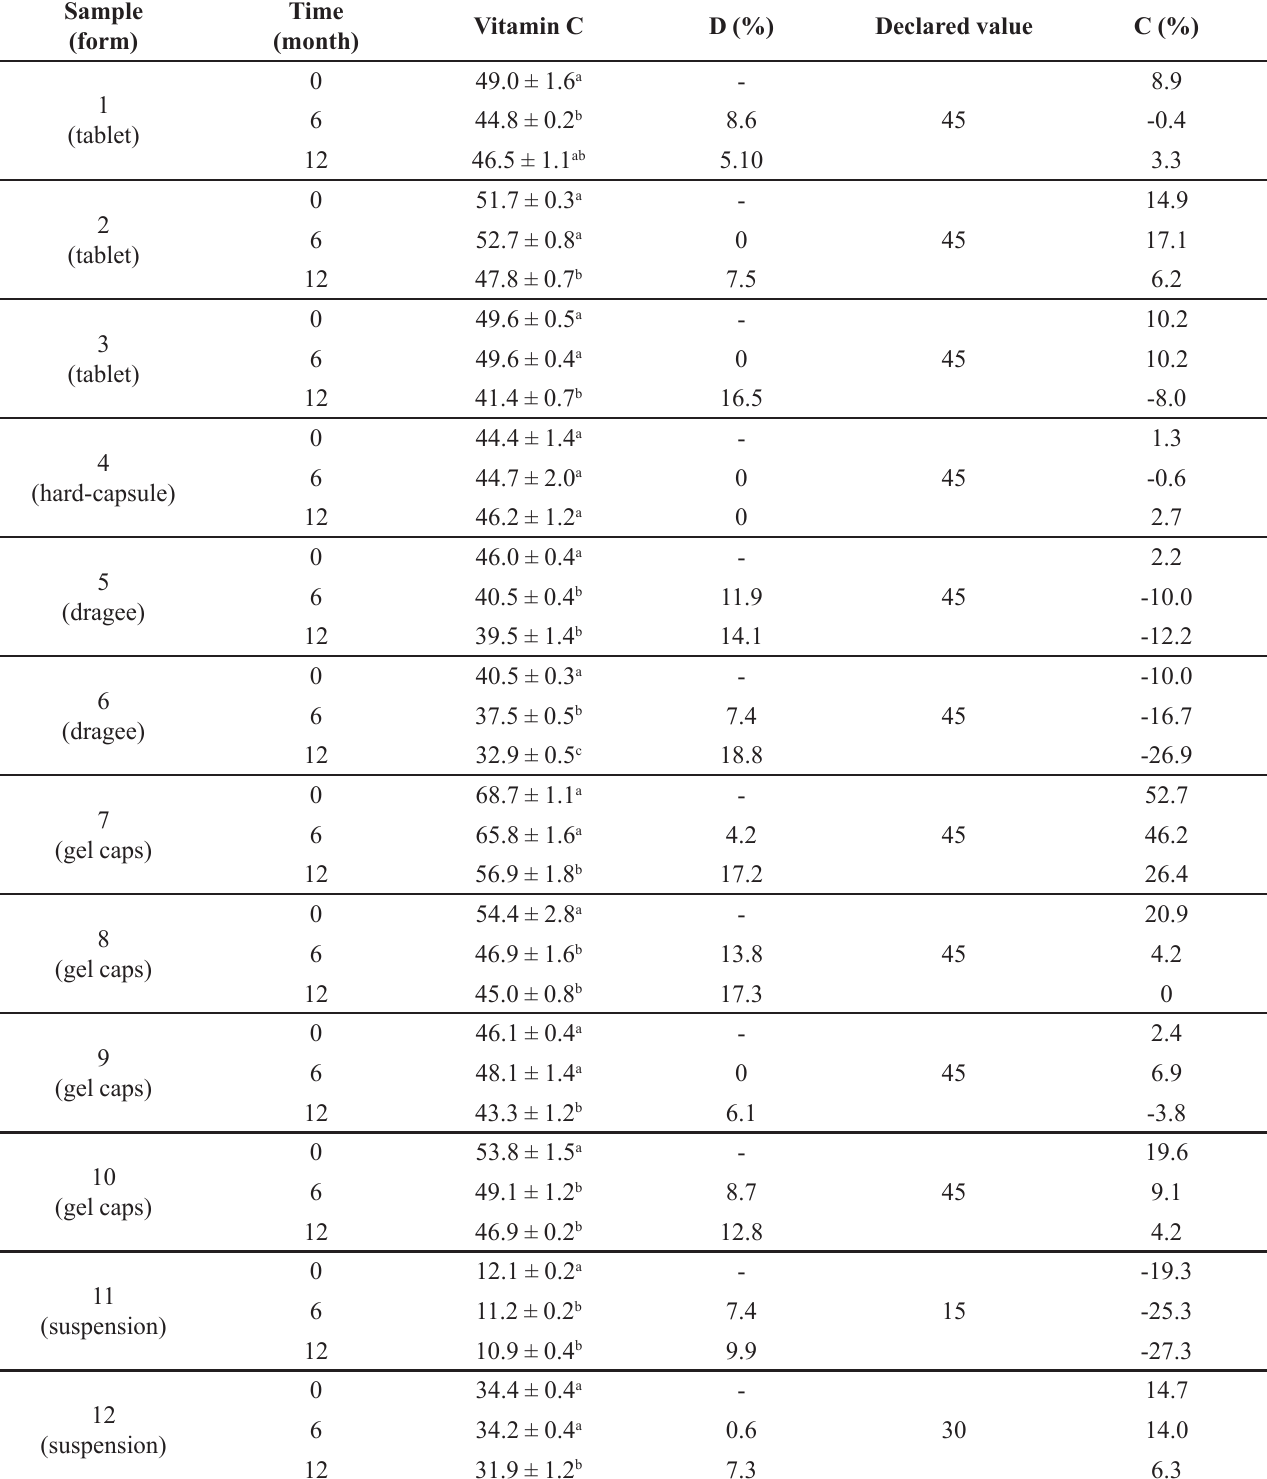
TABLE IV - Analysis of vitamin C (mg/serving) in supplements during storage